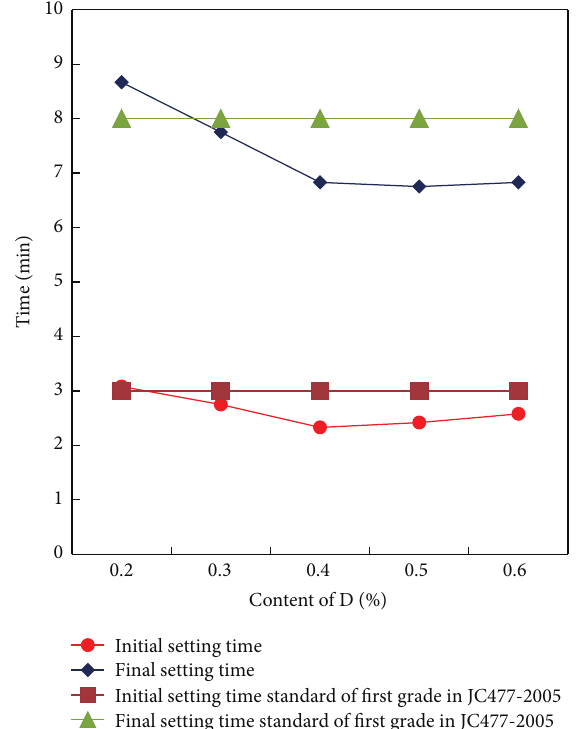
Figure 5: Setting time of cement grout mixing with mother liquid and Material